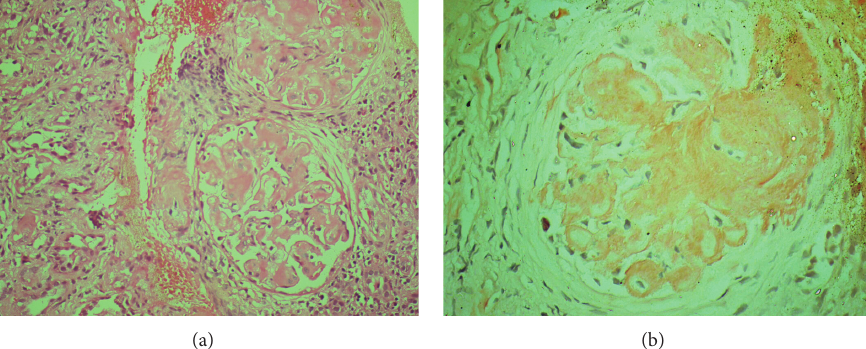
Figure 1: (a) Renal biopsy showing amyloid deposit, pink acellular hyaline material (hematoxylin and eosin stain × 400). (b) Renal biopsy showing congo red positive amyloid deposit, pink acellular hyaline material (congo red stain × 400).